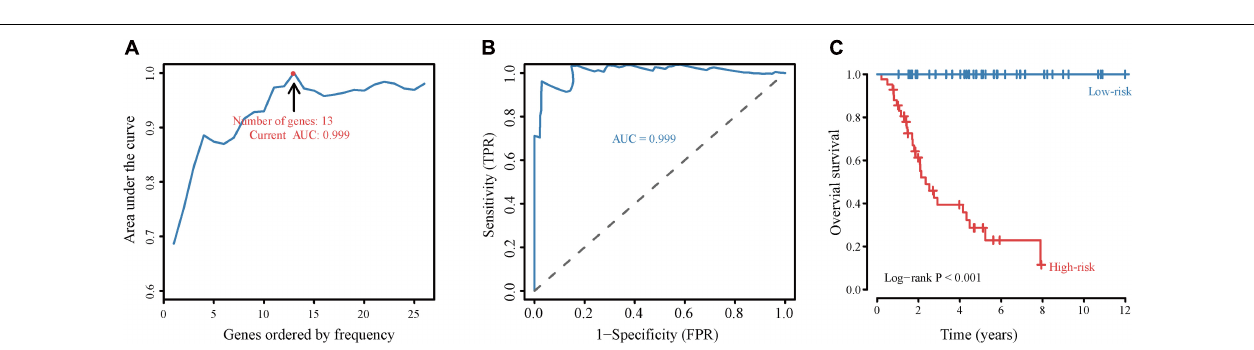
FIGURE 4 | Construction and validation of the autophagy-related lncRNA signature-based prognostic model. (A) Identification of the autophagy-related lncRNA signature by iterative lasso Cox regression analyses. (B) ROC curve showing the prognostic performance of the autophagy-related lncRNA signature. (C) Kaplan-Meier survival analyses of patients in the high-risk score and the low-risk score groups. Patients with high scores (red line) have significantly worse overall survival than those with low scores (blue line); P < 0.05 was considered statistically